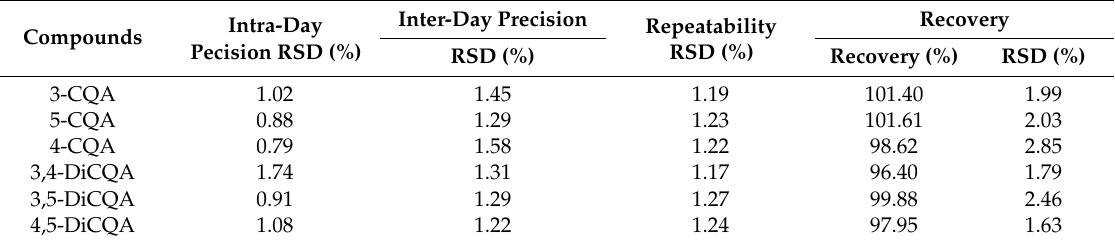
Table 2. Precision, repeatability and recoveries of 6 investigated CQAs.